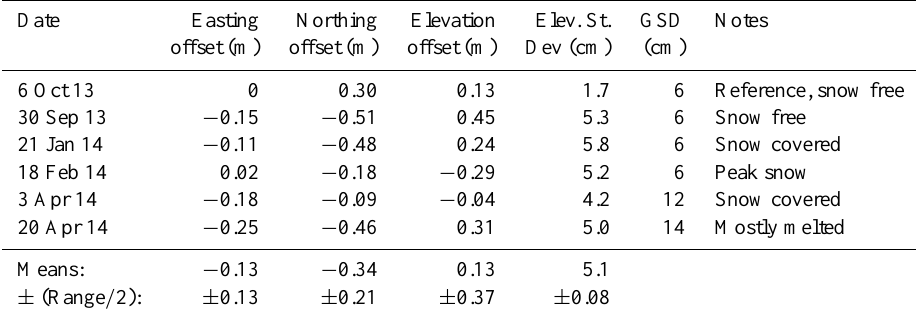
Table 1. Fairbanks International Airport accuracy and precision assessment. Values for the reference DEM (6 October 2013) are geolocation offsets to 29 GCPs. All other offset are co-registration offsets of that DEM minus the reference DEM for the snow-free area of the runway. The group statistics at bottom do not include the reference DEM. The first three columns of numbers represent accuracy, while the fourth represents precision. Easting Northing Elev.